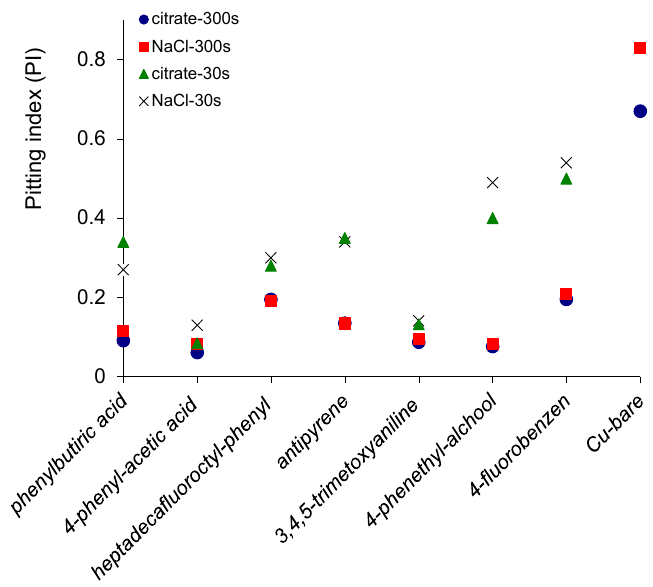
Figure 3. The pitting index obtained for copper surfaces covered with organic layers electrodeposited for 30 and 300 s in citrate buffer and saline solution. For comparison is presented also the pitting index measured for bare copper.